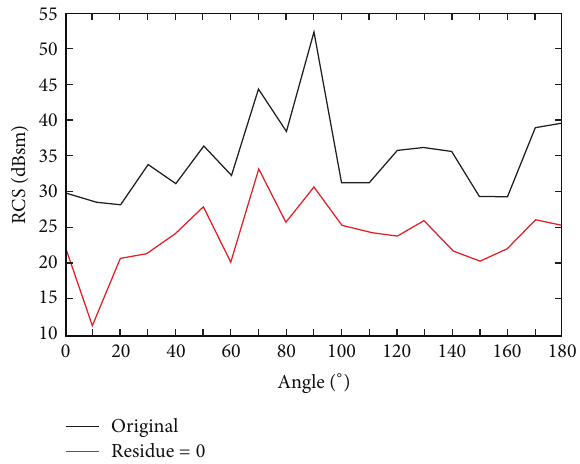
Figure 7: Comparison of RCS between original and residue = 0.